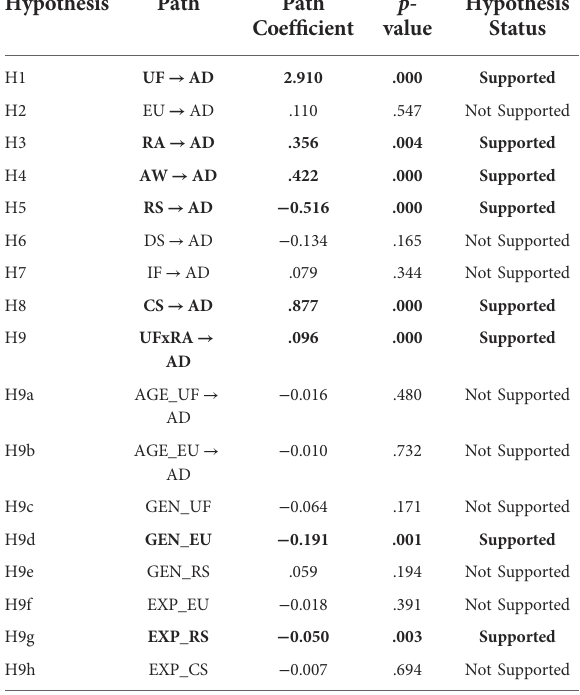
TABLE 4 Hypotheses test results.